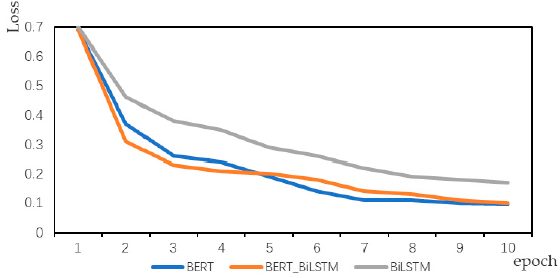
Figure 11. Comparison of convergence